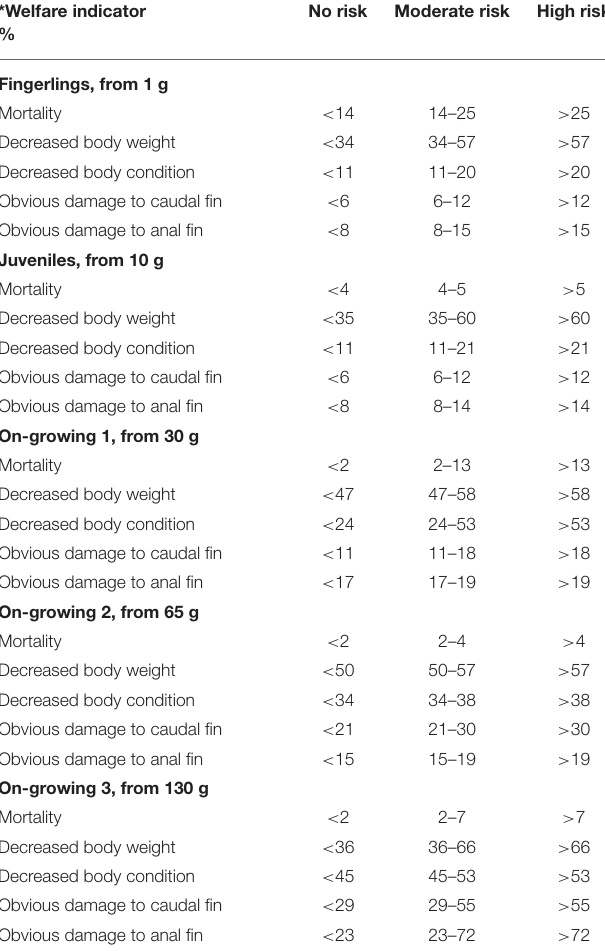
TABLE 3 | Suggested risk limits (%) and color for welfare indicator in relation to the individuals present in the culture